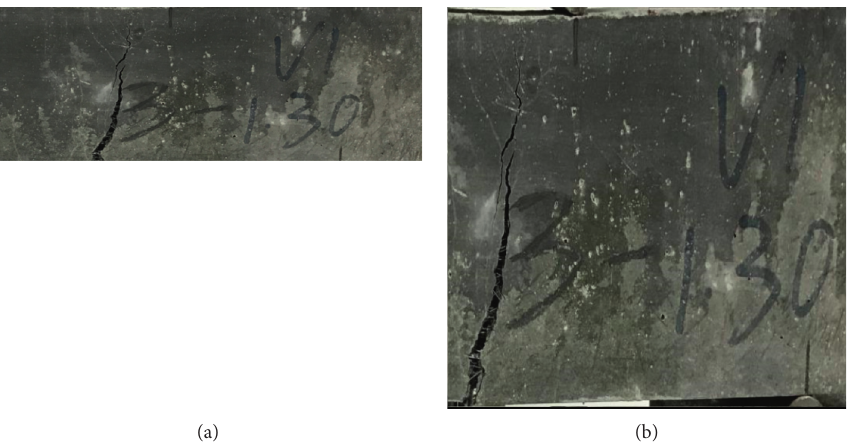
Figure 3: Resizing to 512 × 512. (a) Original picture. (b) Reconstructed images.